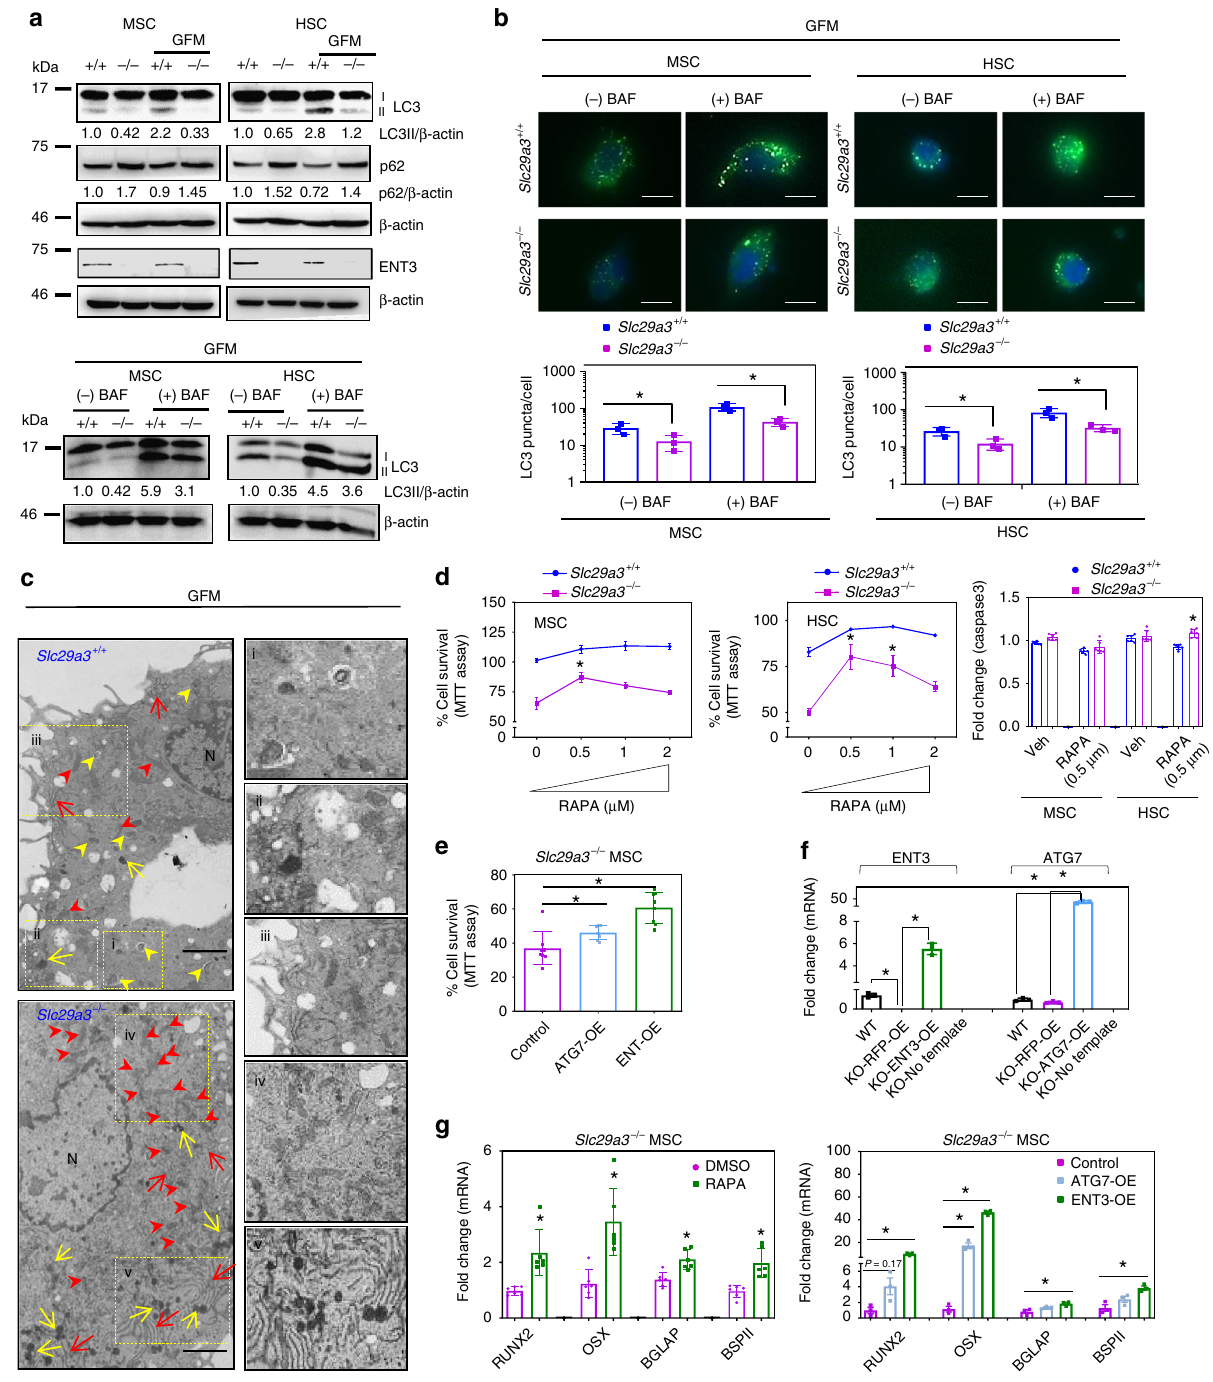
ENT3 loss alters fatty acid utilization and bioenergetics . In the Intriguingly, Slc29a3 − / − livers displayed fewer and smaller lipid droplets (Supplementary Fig. 7a). In addition, BODIPY 493/ 503 staining of neutral lipid droplets was lower in oleic acid- treated Slc29a3 − / − hepatocytes, indicating defects in the forma- tion of lipid droplets (Supplementary Fig. 7b). These observa- tions, along with the perturbation in the major energy and nutrient-sensing pathways (AMPK and mTOR), suggested potential metabolic alterations additionally driving ENT3-related dysfunction in mice. As the formation of neutral lipid droplets largely relies on glucose and patients with PHID syndrome exhibit insulin-dependent diabetes mellitus 6 , we tested whether Slc29a3 − / − mice display an abnormal glycemic pro fi le.